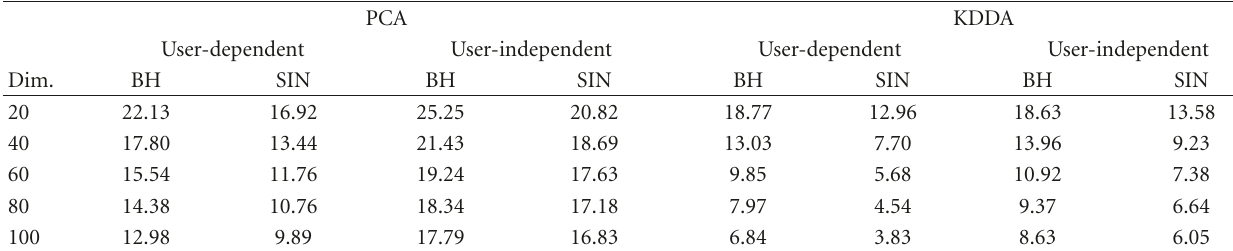
Table 5: Obtained EER (in %) for changeable face